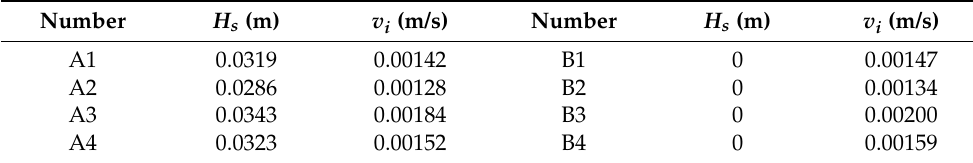
Table 3. The calculated migration speed of ice